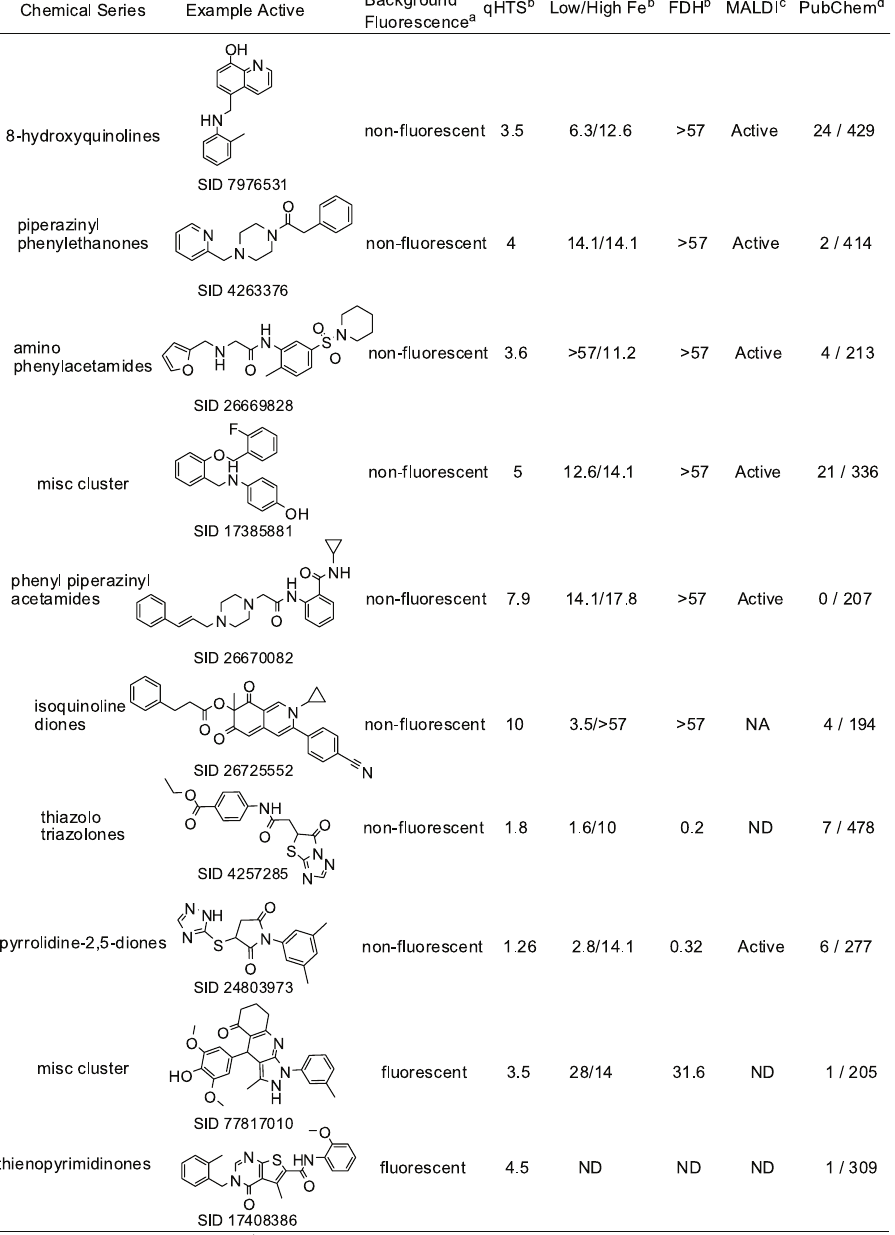
Figure 2. Representative HTS hits. Shown are representative members of clusters along with results from the screen and prioritization experiments.